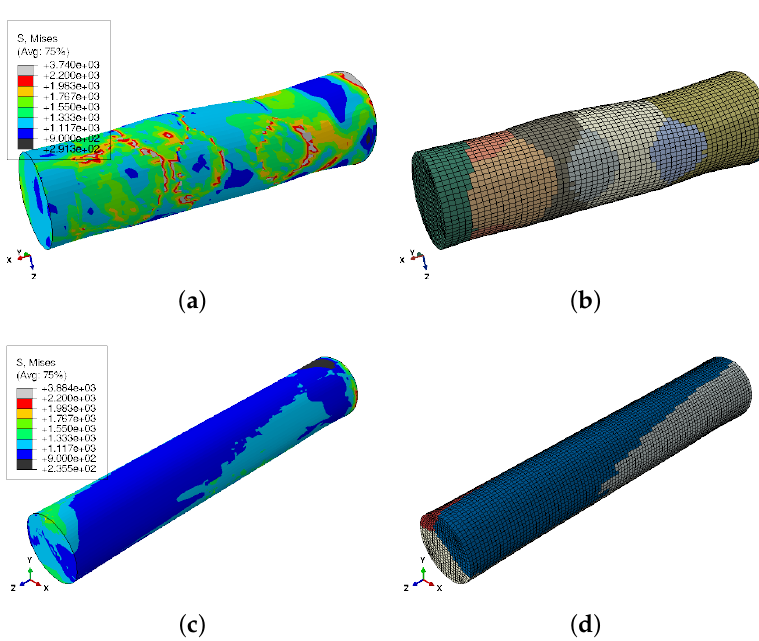
Figure 12. Contour plot ( a , c ) of the von Mises stress for the two different specimen configurations ( b ) = 90 ◦ and ( d ) = 0 ◦ at the last frame. Image on the right represents the deformed grain structure. Stresses are in